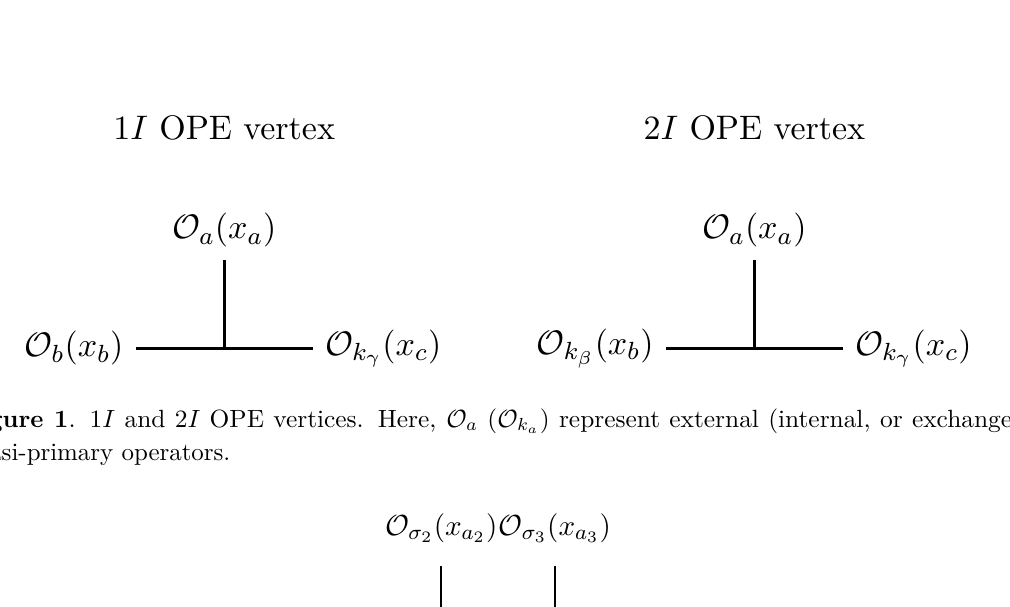
Figure 2 . The four-point structure in which O σ to the 1 I and 2 I OPE vertices depicted in figure 1, respectively. Then, the full leg factor ) can be built by multiplying all L L (∆ , . . . , ∆ 1 M that in figure 1, external operators are indexed by a or b while internal (or